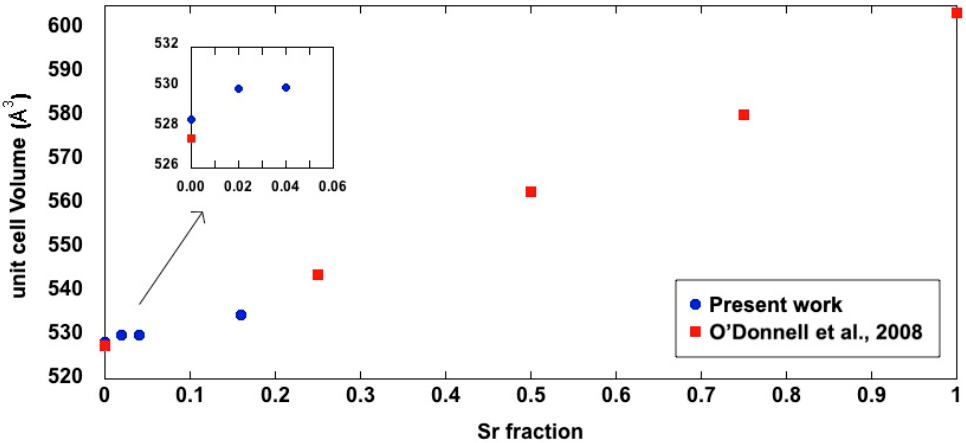
Figure 5. Variation in unit cell volume (Å 3 ) for (Ca 1-x Sr x ) 10 (PO 4 ) 6 (OH) 2 hydroxyapatite samples. Blue circles: present work. Red squares: data from O’Donnell et al., 2008 [45].